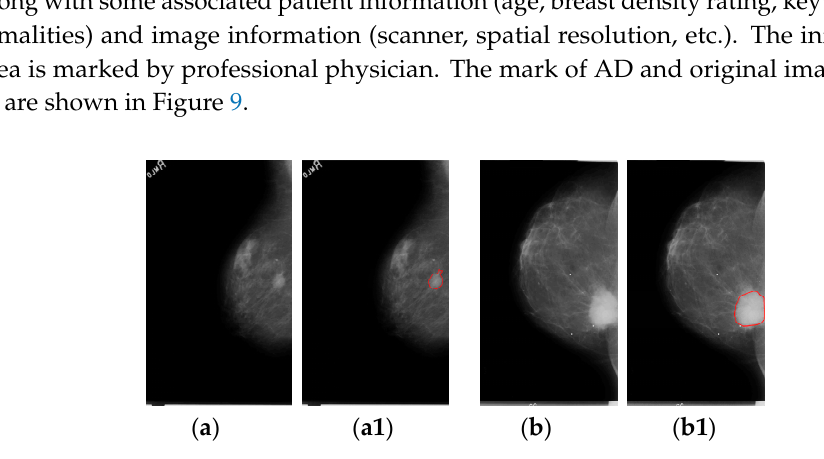
Figure 9. Image with AD in Digital Database for Screening Mammography (DDSM): ( a , b ) are original images; ( a1 ) and ( b1 ) are the AD image marked by the expert.